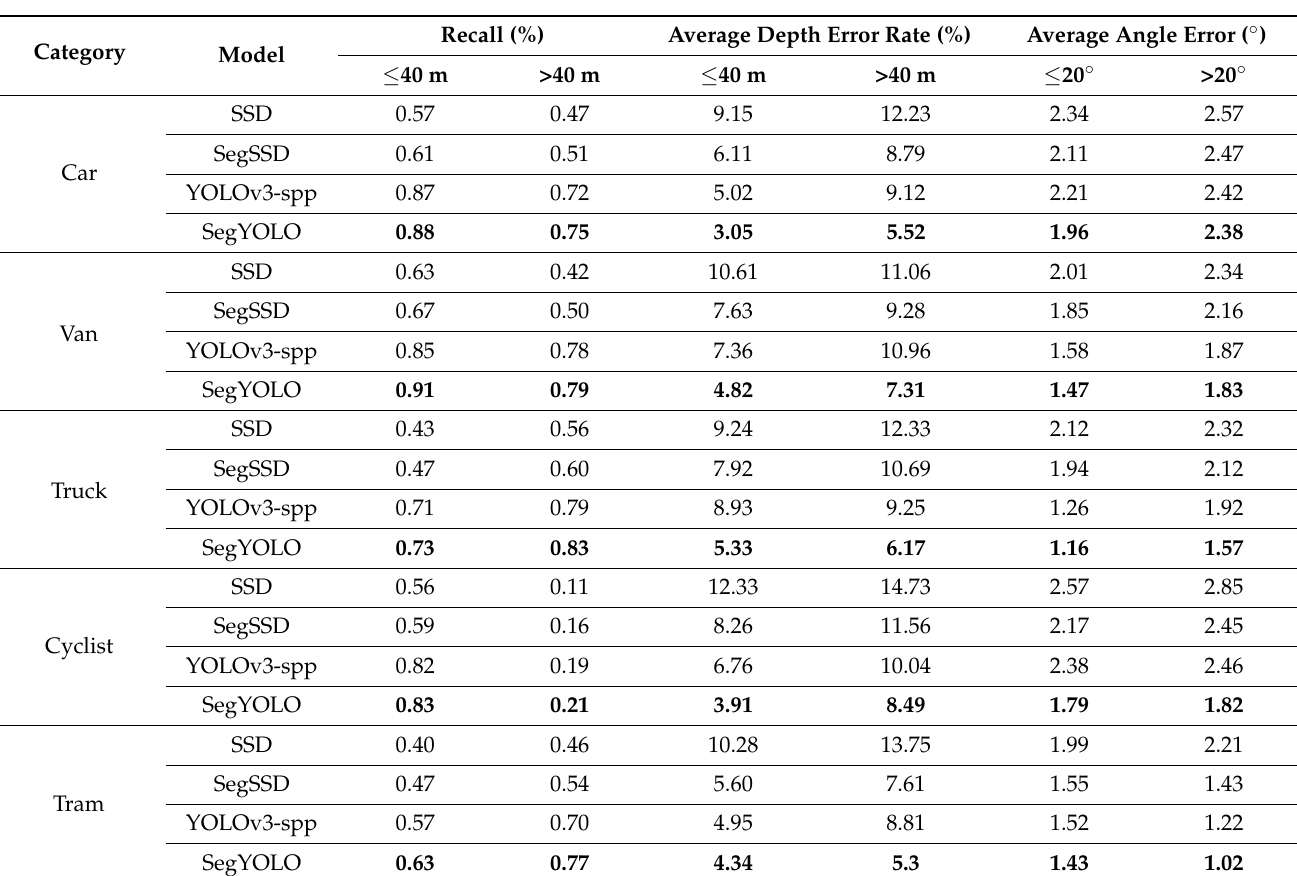
Table 4. The detection results of SSD, SegSSD, YOLOv3-spp, and SegYOLO along with the depth and angle evaluation results pipeline. The confidence thresholds are all set to